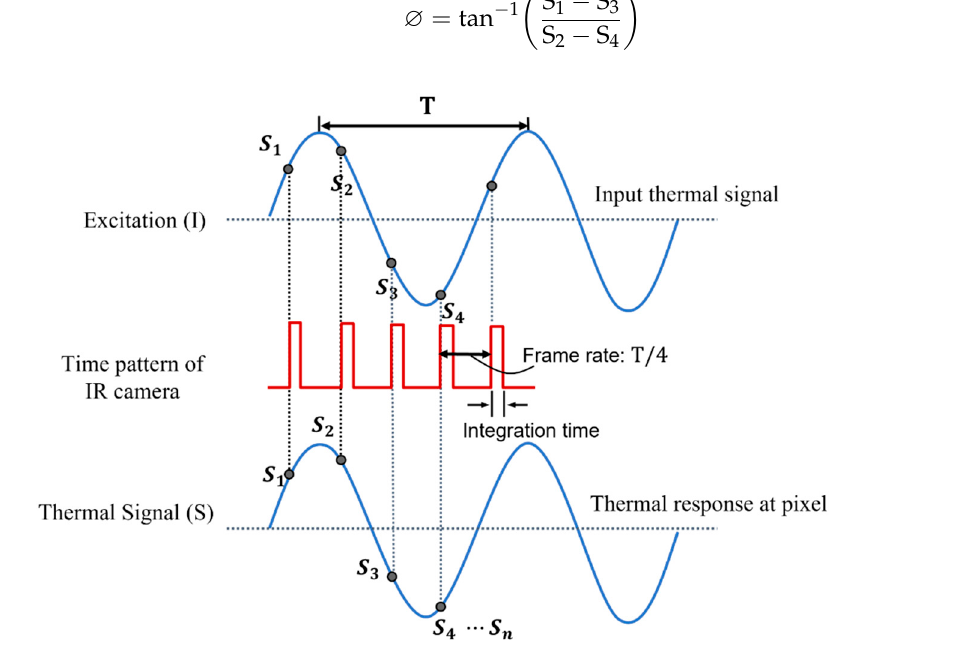
Figure 3. Principle of computation of thermal, amplitude, and phase images by using harmonic ap- Figure 3. proximation.